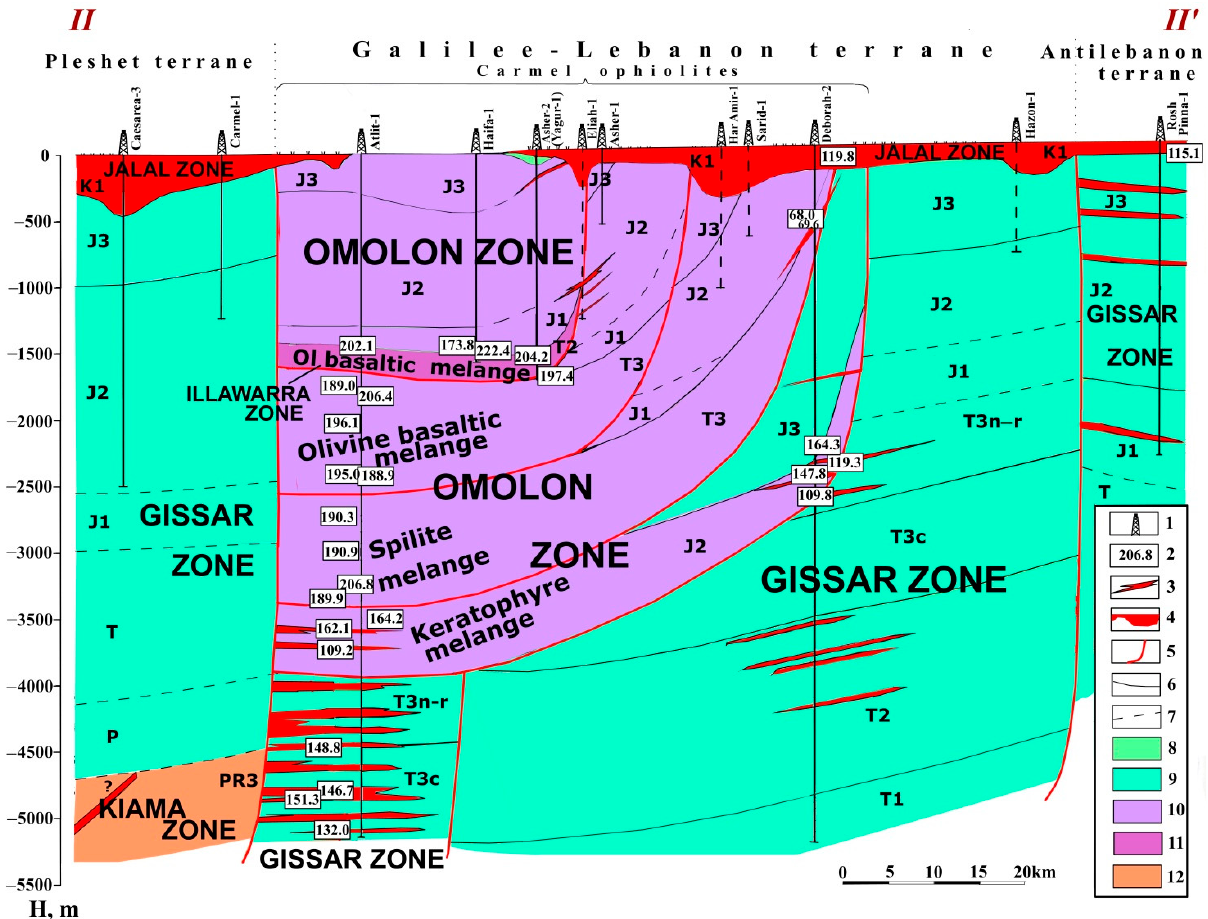
Figure 4. Paleomagnetic profile II – II ′ of the Carmel-Galilee region along the top of the accumulative surface of the Lower Cretaceous traps (location of this profile is shown in Figures 1 and 2). (1) borehole, (2) radiometric age, (3) dykes and sills, (4) traps, (5) faults, (6) established stratigraphic boundaries, (7) supposed position of the stratigraphic boundaries, (8–12) paleomagnetic zones: (8) Jalal, (9) Gissar, (10) Omolon, (11) Illawarra, (12) Kiama. The following main works were used for this map construction: [32,54,55,60,61,63,78,89].